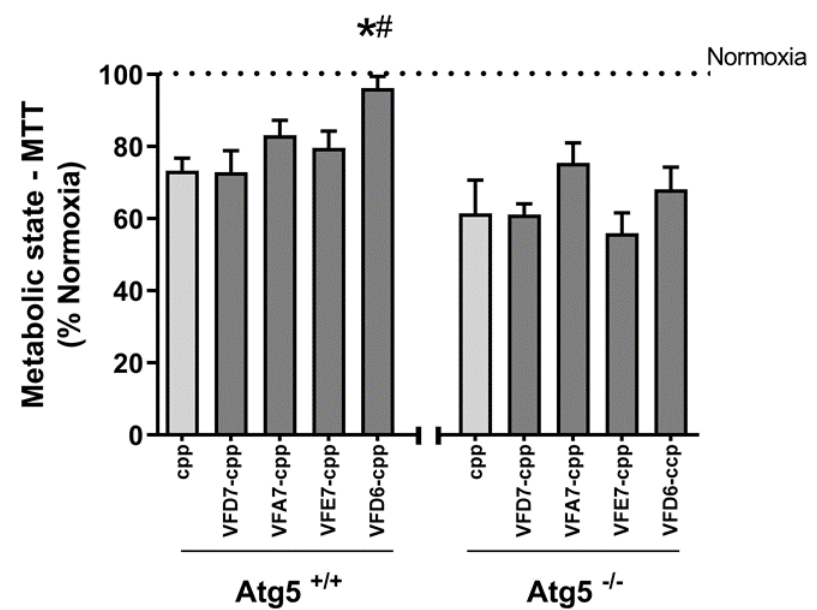
Figure 9. Atg5 wild type (Atg5 +/+ ) and Atg5 knockout (Atg5 −/− ) MEF cells were cultured in a 96-well plate in DMEM high-glucose medium supplemented with 10% FBS and 1% penicillin/streptomycin. Cells were washed with PBS and incubated at 37 °C for 3 h in hypoxia buffer, and then re-exposed to oxygen as detailed in Experimental procedures. Treatments with 1 µ M of each indicated peptide, commenced 30 min before ischemia, and continued during hypoxia and reoxygenation. A booster with the same initial concentration of the peptide was added with the hypoxia buffer incubation and the reoxygenation buffer incubation. Cell viability was measured by MTT assays. Statistics were conducted using ANOVA one-way with post hoc Tukey ’ s. *, p < 0.05 vs. cpp Atg5 + / + ; #, p < 0.05 vs. VFD7-cpp Atg5 + / + ; n = 3 independent experiments.